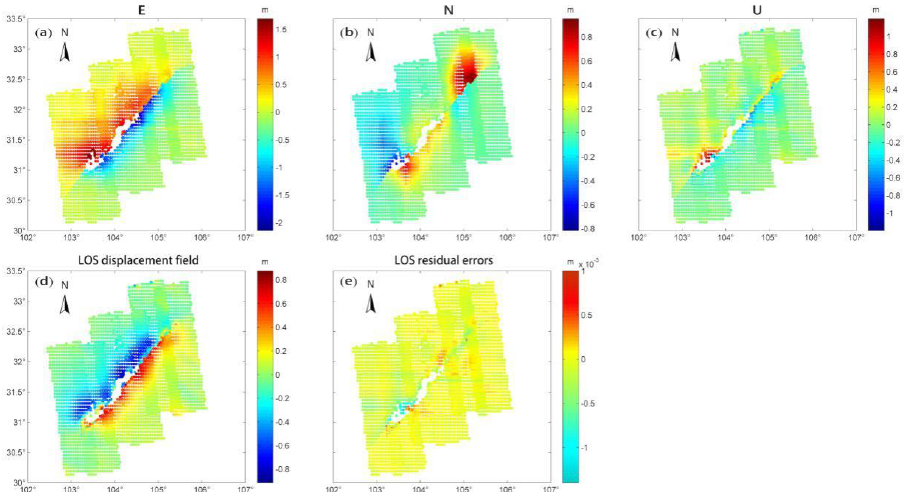
Figure 9. The results obtained by the VOILS method, ( a ), ( b ), and ( c ) are the deformations of E, N, and vertical (U) directions, respectively. ( d ) is the modelled LOS displacement field. ( e ) are the residual errors between the modelled and observed LOS displacements.